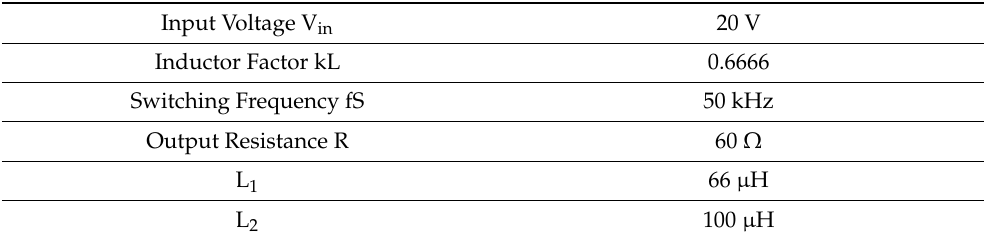
Table 1. Parameters for simulation setting.